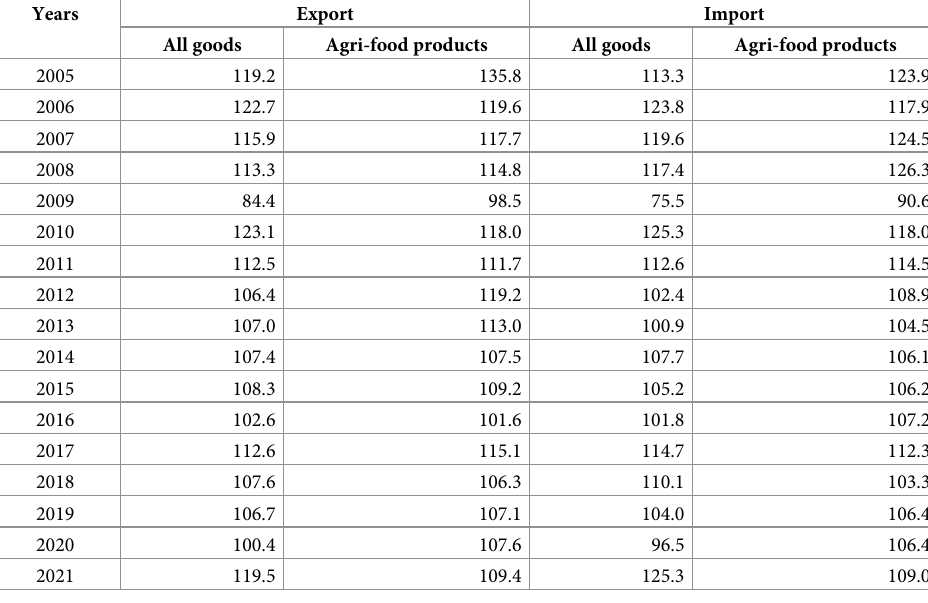
Table 1. Dynamics of polish foreign trade in 2005–2021 (previous year = 100). Years